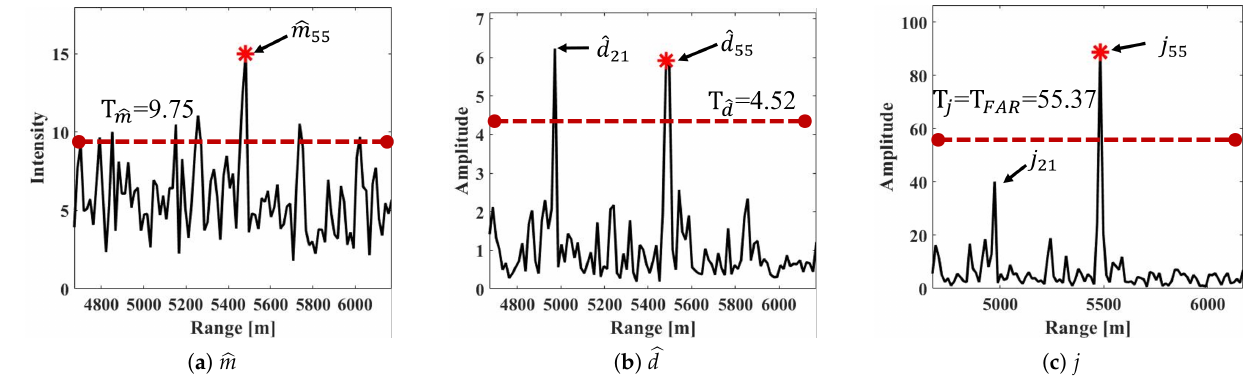
Figure 3. Discriminant feature of a target range bin (55th range bin) and clutter